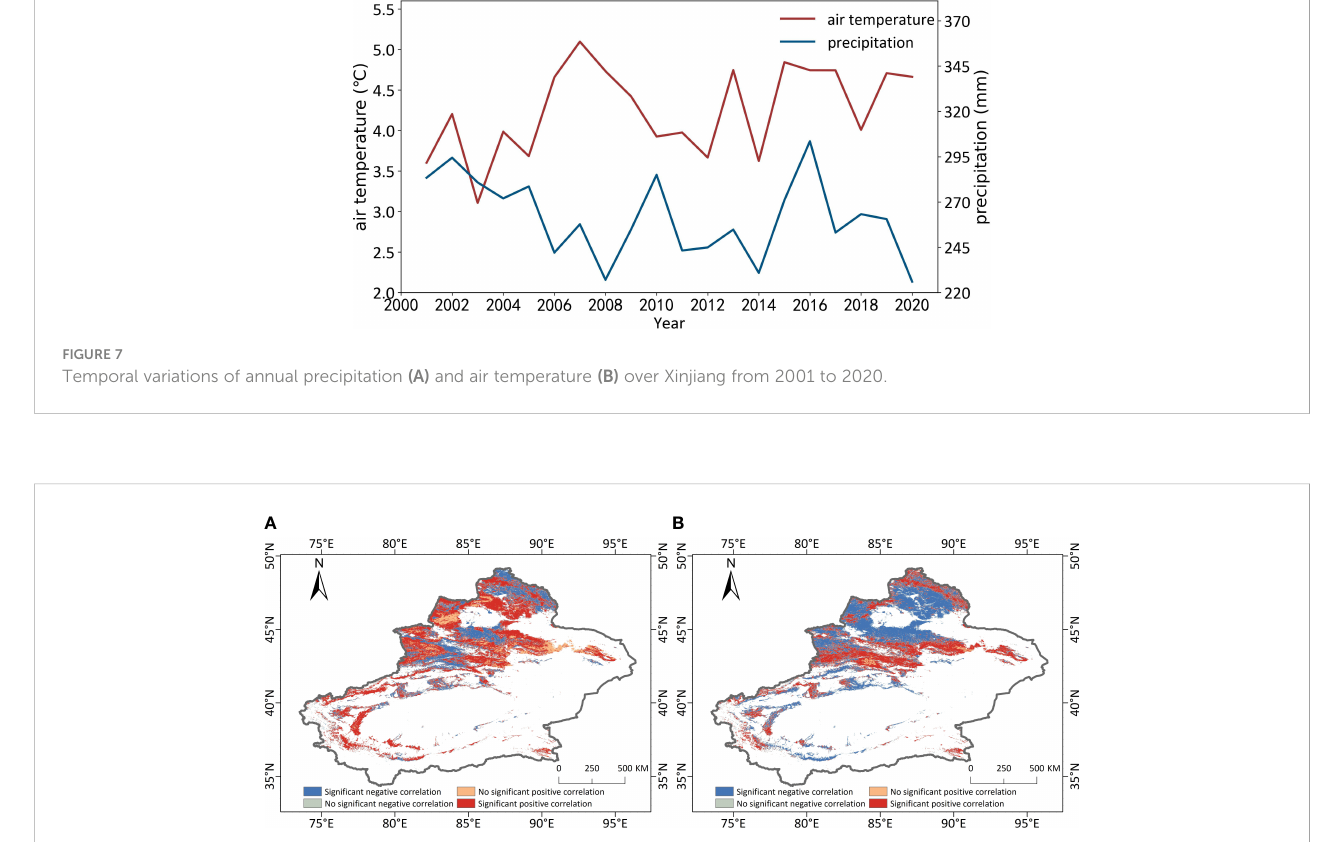
FIGURE 8 Spatial distributions of the signi fi cance of the partial correlation between annual NEP and precipitation (A) and air temperature (B) over Xinjiang from 2001 to